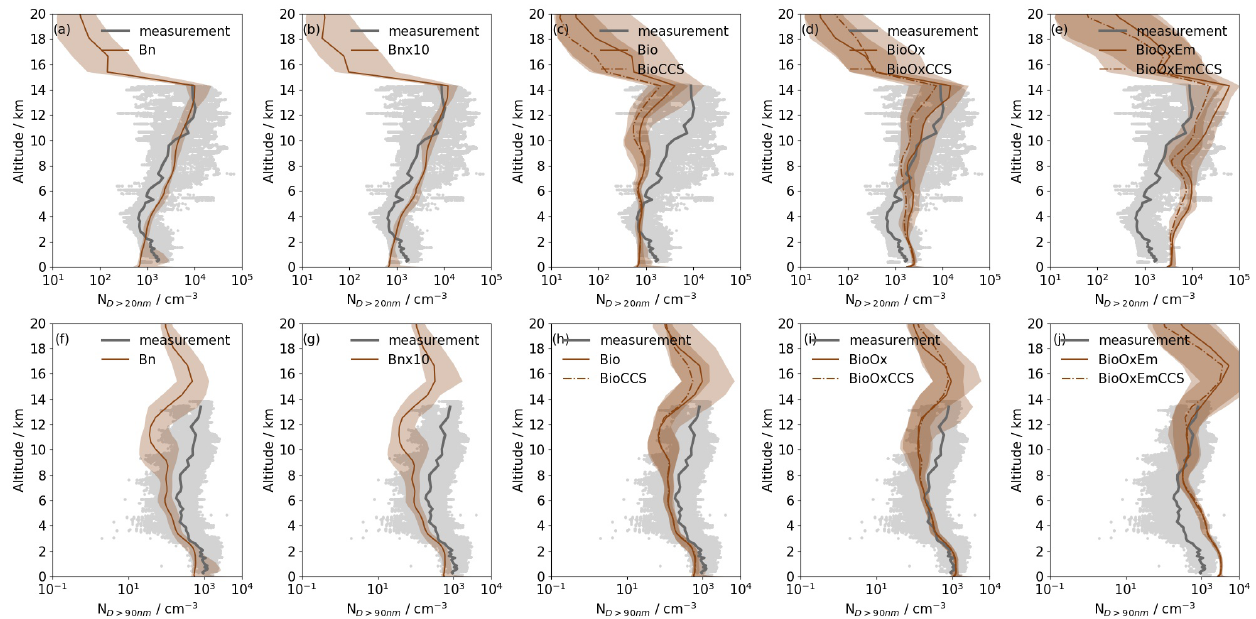
Figure A1. The observed and modelled vertical profiles of median number concentrations of particles with diameters > 20nm ( N D> 20nm , a – e ) and > 90nm ( N D> 90nm , f – j ). The observations are shown in dots and grey line (repeated for all panels), and the modelled results are from the various regional simulations averaged from 00:00UTC on 17 September to 23:00UTC on 18 September 2014, (a) and (f) Bn, (b) and (g) Bn × 10, (c) and (h) Bio and BioCCS (dashed line), (d) and (i) BioOx and BioOxCCS (dashed line), and (e) and (j) BioOxEm and BioOxEmCCS (dashed line), corrected to standard temperature and pressure (Eq. 2). The shading represents 2.5% and 97.5% percentiles from the modelling results. The grey dots are individual observations from all flights during ACRIDICON-CHUVA with a time resolution of 1min, and the thick grey lines are the medians of the observations binned within the same height ranges as the regional model levels.